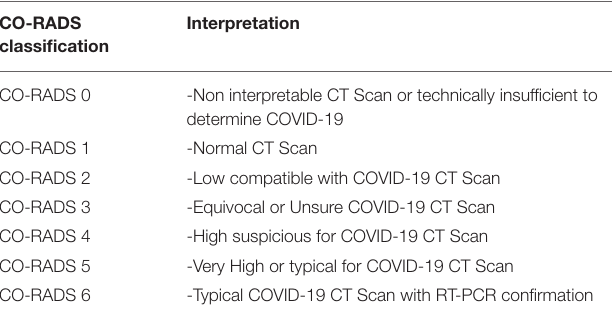
TABLE 1 | The coronavirus disease 2019 reporting and data system (CO-RADS).